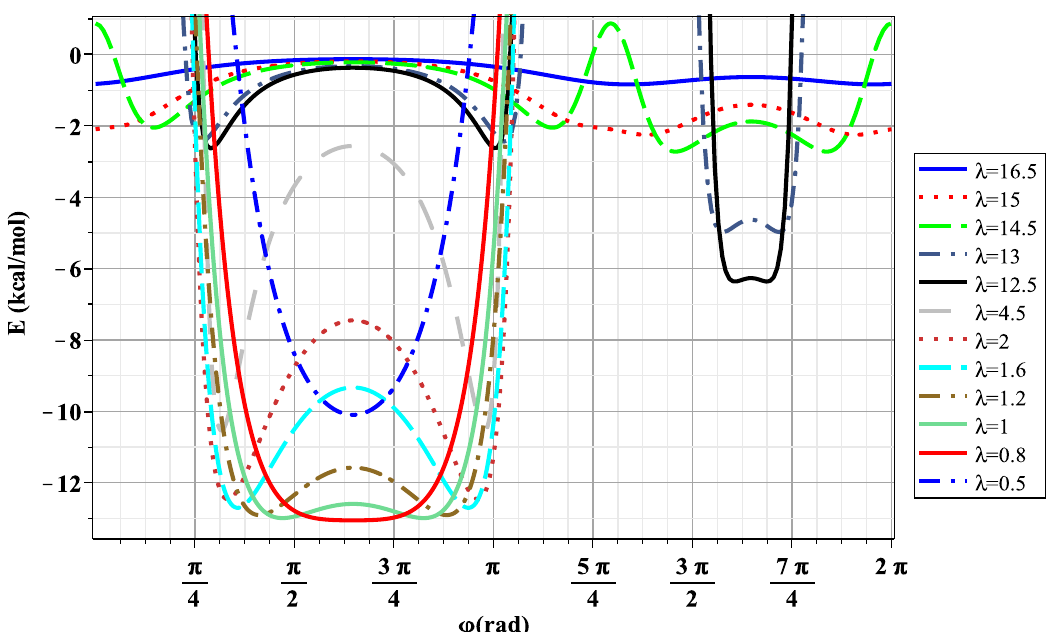
Figure 6. Energies of Cis molecules binding to dsDNA with respect to ϕ for ψ = 12 π